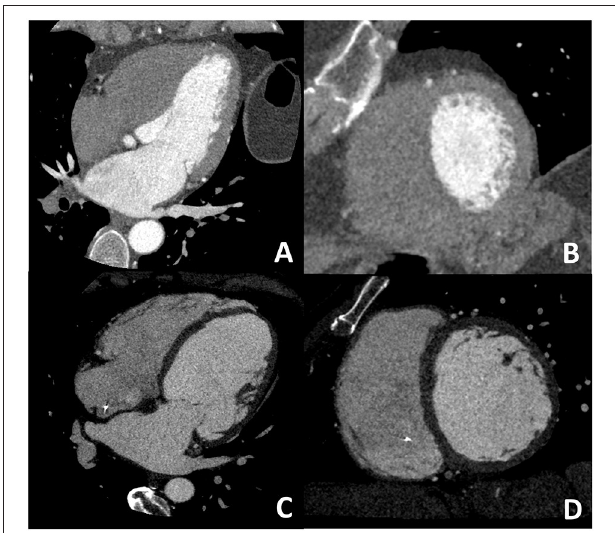
FIGURE 3 | Dedicated cardiac CT (CCT) scan protocol for the comprehensive evaluation in DCM patients. In (A,B) a cardiac CT dedicated to coronary anatomy evaluation is shown; it is well evident how it is not possible to correctly identify the right ventricular border of the interventricular septum. In (C,D) a CT with dedicated acquisition protocol for biventricular volume and function in which all four chambers are opacified by contrast medium enabling correct right ventricular border identification. These examples highlight the need for a dedicated acquisition protocol for most of the non-coronary cardiac CT